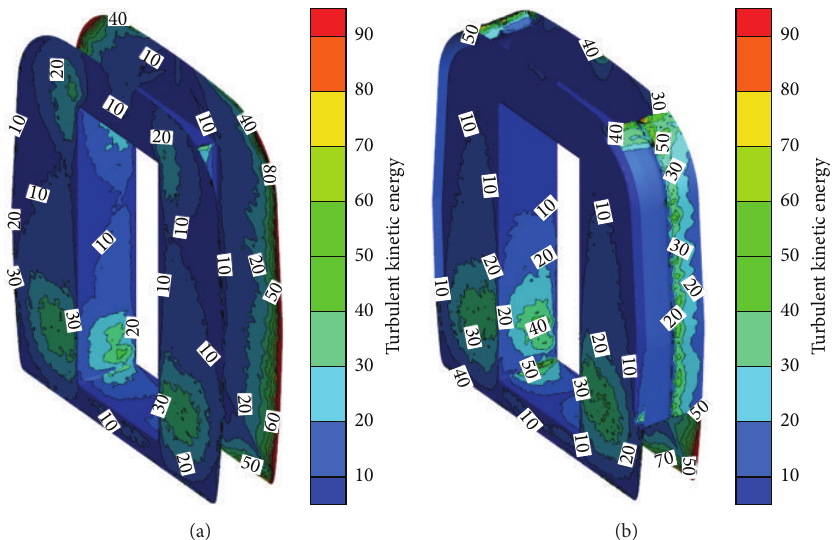
Figure 30: TKE distributions in the second inter-coach spacing: (a) Fd2 and (b) Fd3.